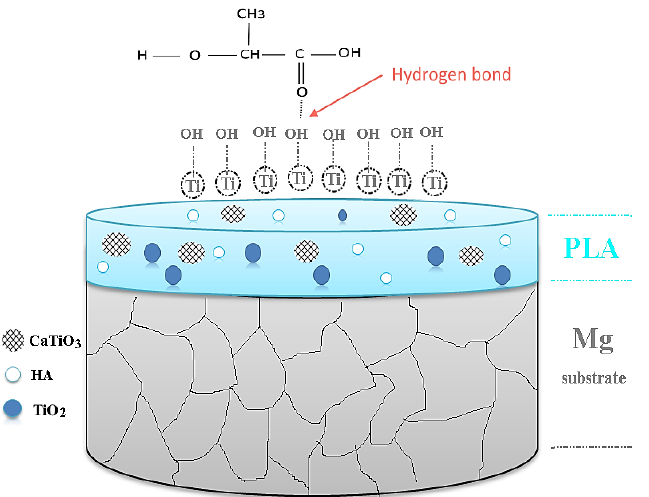
Figure 3. Sketch of adhesion mechanism of HA/CaTiO 3 /TiO 2 /PLA coating. Reprinted with permis- sion from [35]; Copyright 2016 Elsevier.